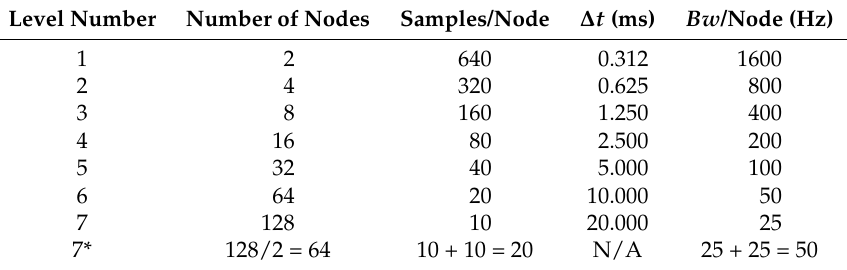
Table 1. Decomposition tree